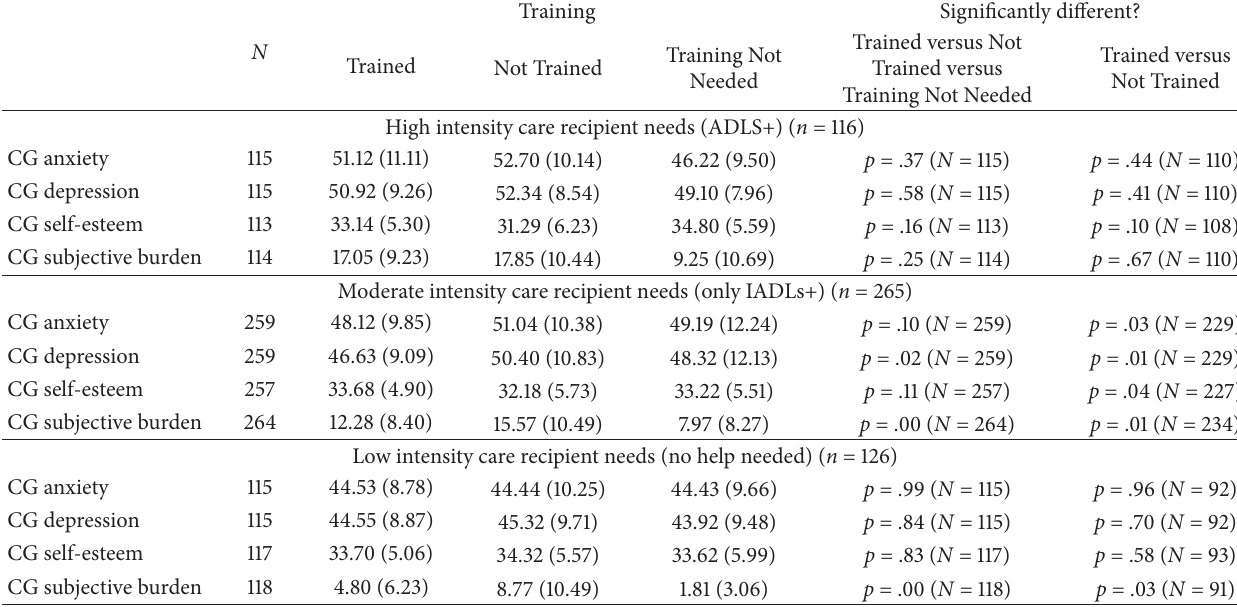
Table 7: Differences in caregiver mental health based on training received for supporting emotions based on intensity of care recipient’s needs.